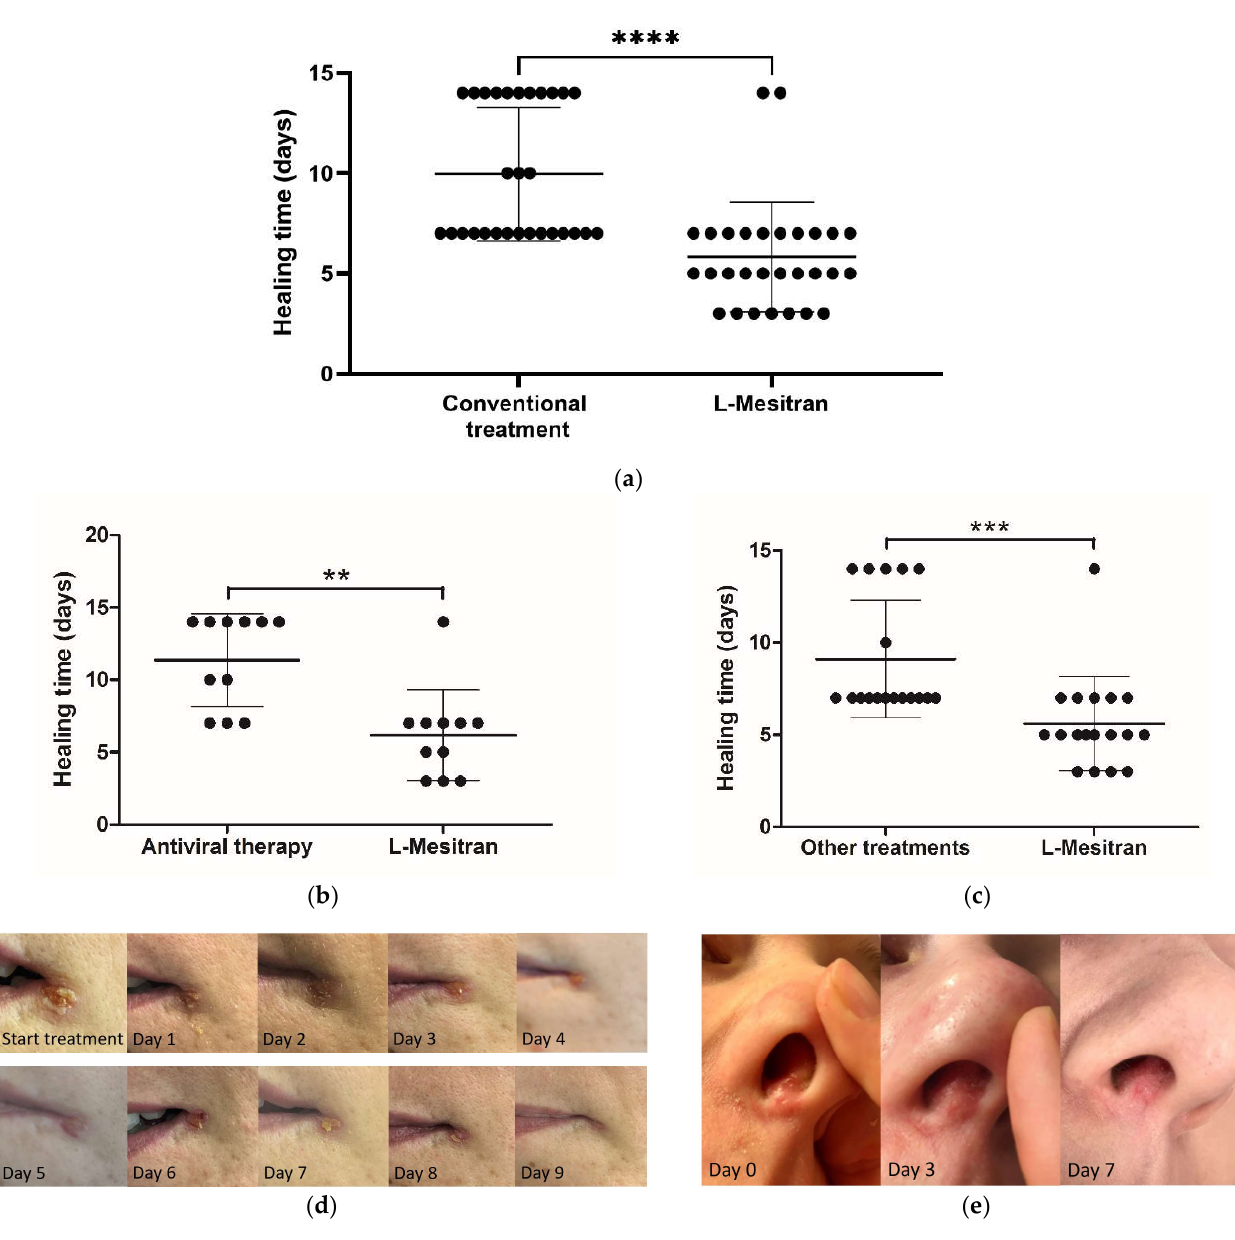
Figure 2. L-Mesitran reduces the healing time of cold sores compared to conventional treatment. ( a ) Dotplot of absolute healing time in days for both conventional and L-Mesitran treatment, each dot represents one patient ( n = 29). ( b ) Dot plot of absolute healing time of the subpopulation who use antiviral acyclovir-based therapy (Zovirax, herpesin, or vectavir). ( c ) Dot plot of absolute healing time of the subpopulation who use other treatments and do not use antiviral therapy as conventional treatment. ( d ) Representative example labial cold sore. Normally, with conventional treatments healing takes 14 days, but healing was achieved within 9 days with L-Mesitran. ( e ) Representative example nasal cold sore. Normally, healing takes 14 days, but with L-Mesitran it was healed in 7 days. Significant differences between the groups are indicated by ( ** p < 0.01, *** p < 0.001, **** p < 0.0001).